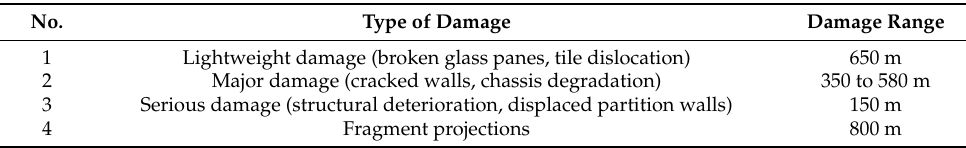
Figure 6. DSC analysis of AN and PP mixture (containing 20% of the polymer) for different heat rates. Table 2. Damage extent and types after the explosion 1